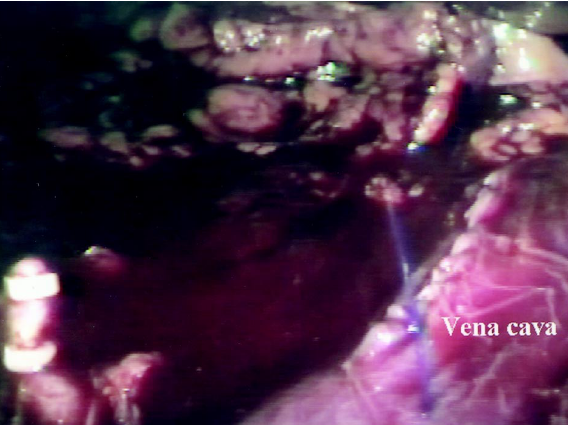
Figure 1 – Placement of the Satinsky clamp on the inferior vena cava.